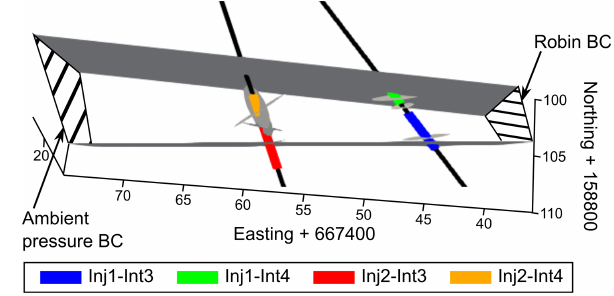
Figure 3. Overview of the volume considered in the forward model and the boundary conditions (BCs). The geometry of the S3 faults is simplified to planes, and the fractures intercepted by the injection intervals are illustrated as plane